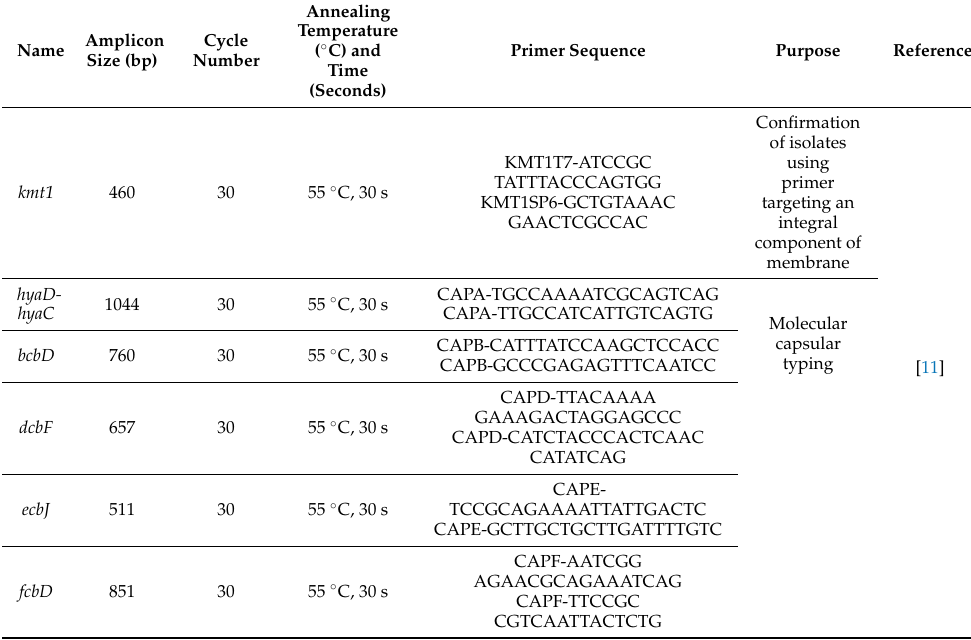
Table 2. Primer sequences, anticipated amplicon size, and amplification